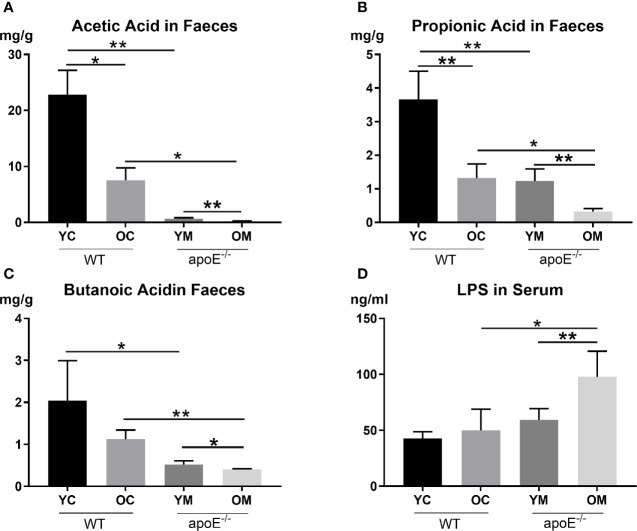

(A–C) Quantification of SCFAs levels in fecal, n=4 in each group; (D) Quantification of serum LPS level, n=4 in each group. Data were shown as mean ± SD. *p <0.05; **p <0.01. p values are calculated from T-test.